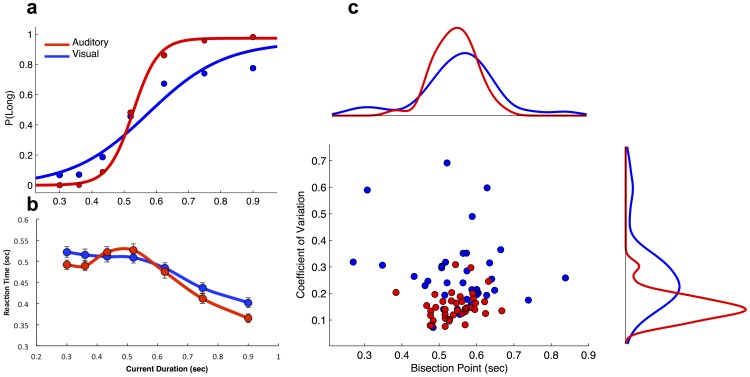
Direct effects of duration.(a) Temporal bisection performance for two representative subjects on different modality versions of the task. The probability of categorizing each duration as Long as well as the best fitting logistic function are displayed. (b) Average chronometric functions for auditory and visual participants. Reaction time decreased as a function of duration, but dropped off faster after the BP was passed and was faster for auditory stimuli at the longest duration tested. Error bars indicate s.e. of the mean. (c) Individual participant performance for the bisection point (x-axis) and coefficient of variation (y-axis) values derived from psychometric data, as well as marginal histograms for each; there were no differences between BP values for auditory or visual participants, but significantly lower CV values for the auditory task.